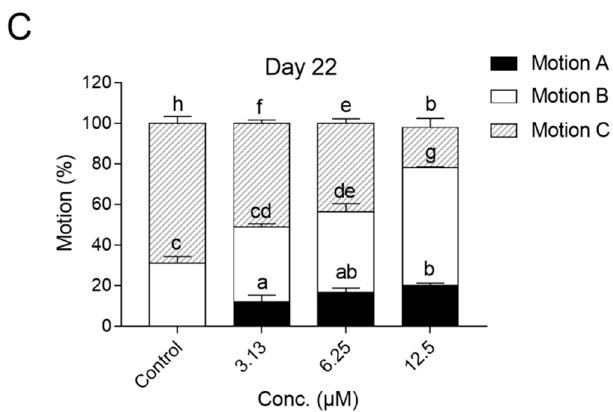
Figure 3. Effect of NOB on motility of ( A ) day 14, ( B ) day 18, and ( C ) day 22 experimental animals. Nematodes were classified into three groups based on motility: group A animals moved spontaneously and freely; group C animals only moved their heads in response to stimulating heads and tails; and group B animals were distributed between these two situations. NOB potently alleviated the decline of in motility in a dose-dependent manner. ( n ≥ 40 animals per group for days 14 and 18; n ≥ 25 for day 22). Bars with different letters indicated statistical significance ( p < 0.05).